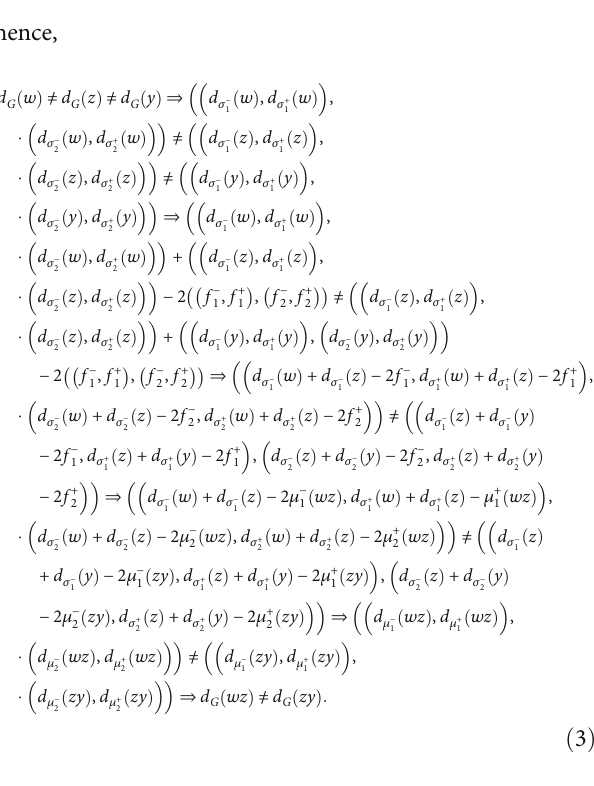
Figure 2: G is NEI-IVIFG but it is not